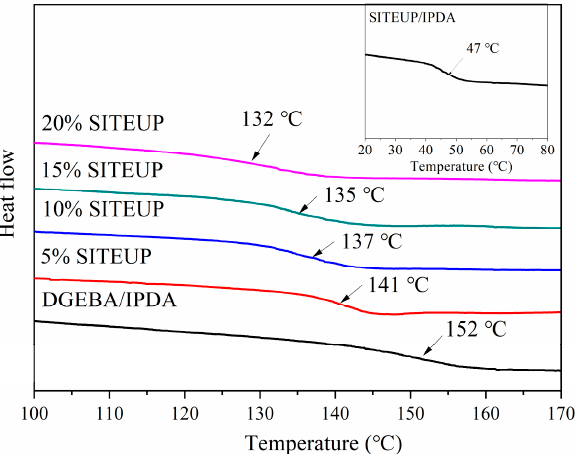
Figure 5. Glass transition temperatures of DGEBA/IPDA thermosets modified with different contents of SITEUP.